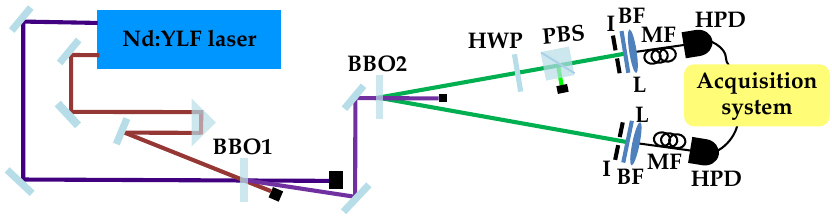
Figure 3. (Color online) Sketch of the experimental setup. See the text for